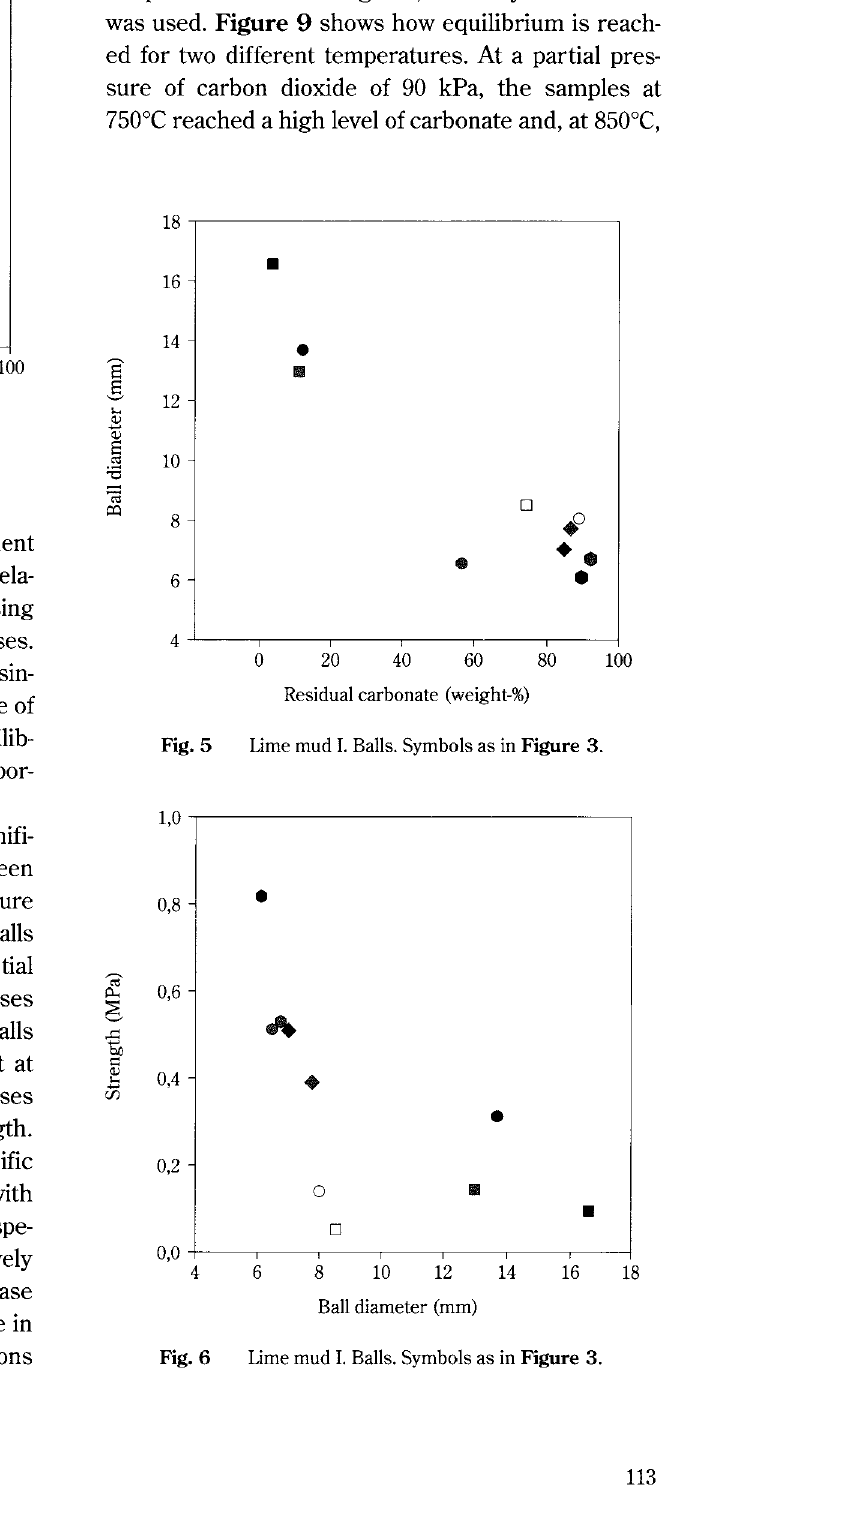
Fig.6 Lime mud I. Balls. Symbols as in Figure